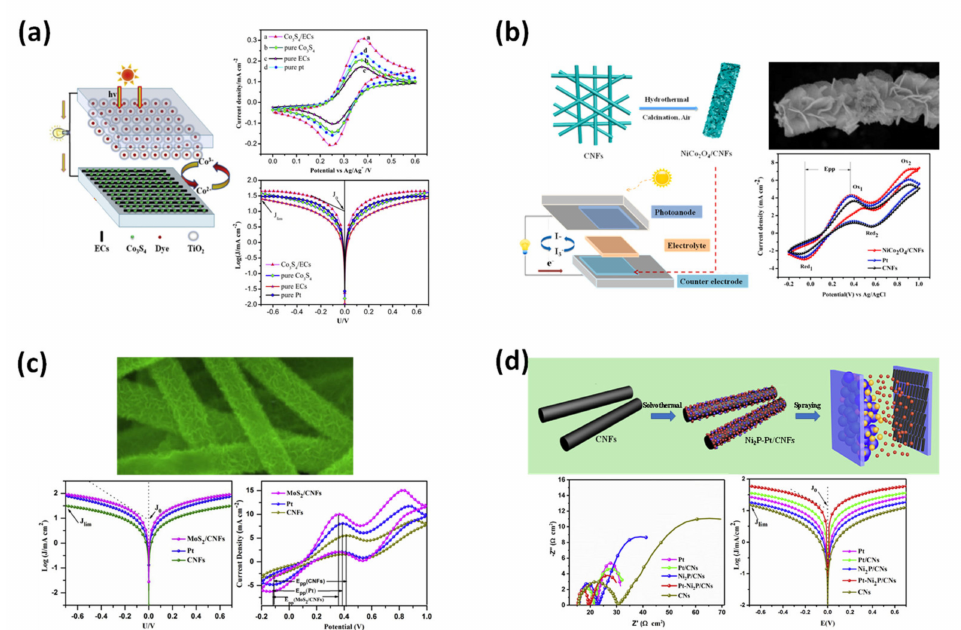
Figure 15. ( a ) CNFs decorated with Co 2 S 4 and the performance in DSSC device [109]. ( b ) Flower- petal − like SiCo 2 O 4 grown on CNFs used as counter electrode for DSSC [110]. ( c ) CNFs grow MoS 2 mini − sized petals for solar systems [111]. ( d ) CNFs decorated with Ni2P and Pt nanoparticles for the application of the DSSC counter electrode